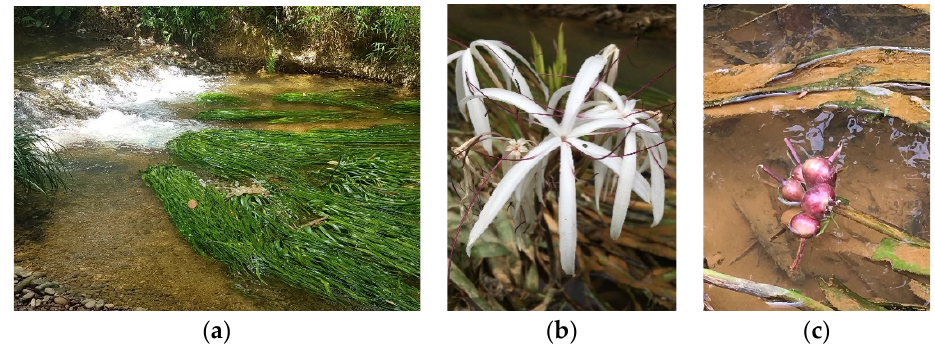
Figure 1. Crinum thaianum : ( a ) habit showing extremely long flat leaves; ( b ) inflorescences; ( c ) fruit- ing inflorescence.